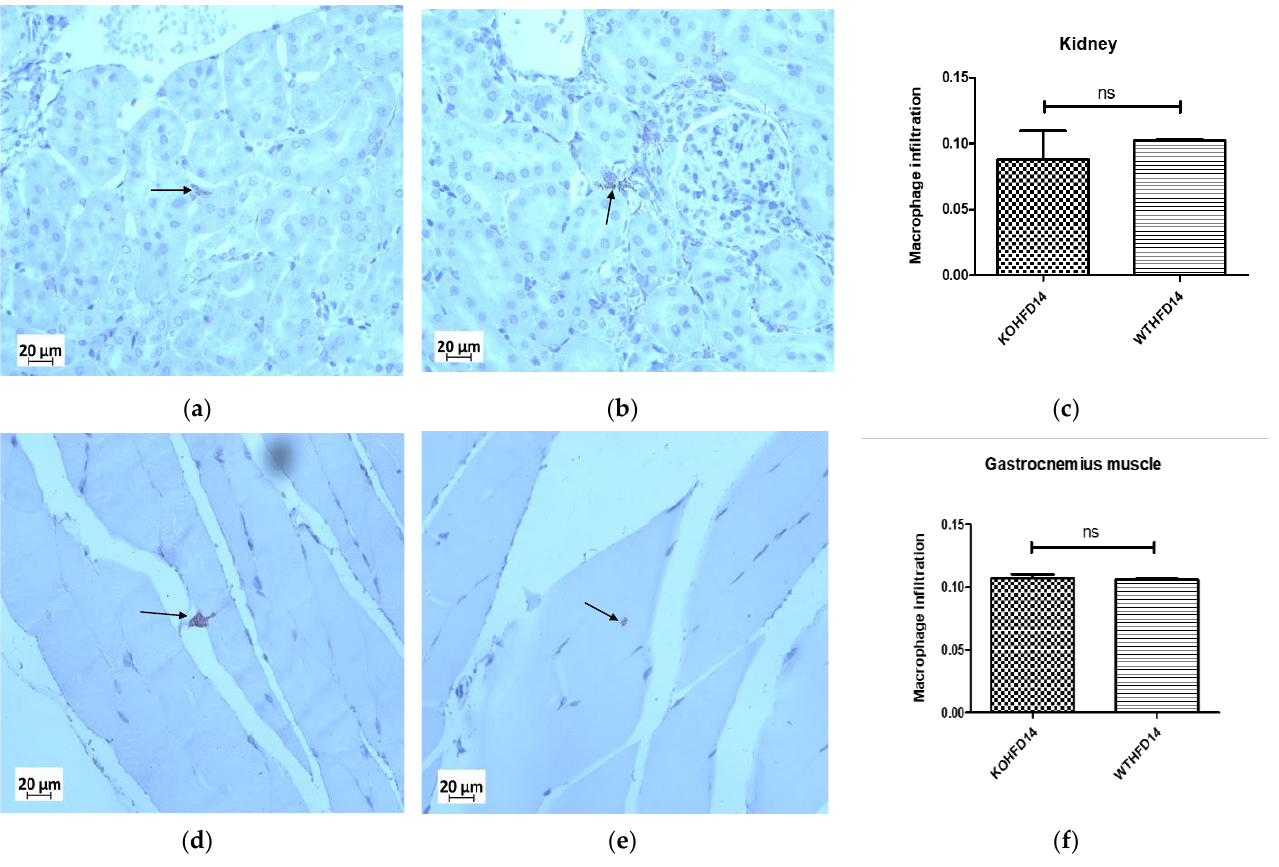
Figure 13. Effect of slc7a8 on macrophage infiltration profiles of the kidney and gastrocnemius muscle. KOHFD ( a ) had slightly fewer macrophages infiltrating into the kidney ( c ) than WTHFD ( b ). However, no significant differences were noted between KOHFD and WTHFD. No significant differences ( f ) were observed in infiltration between the gastrocnemius muscles of KOHFD ( d ) and WTHFD ( e ). Magnification = 40×. Scale bar = 20 µm. N = 5 fields .